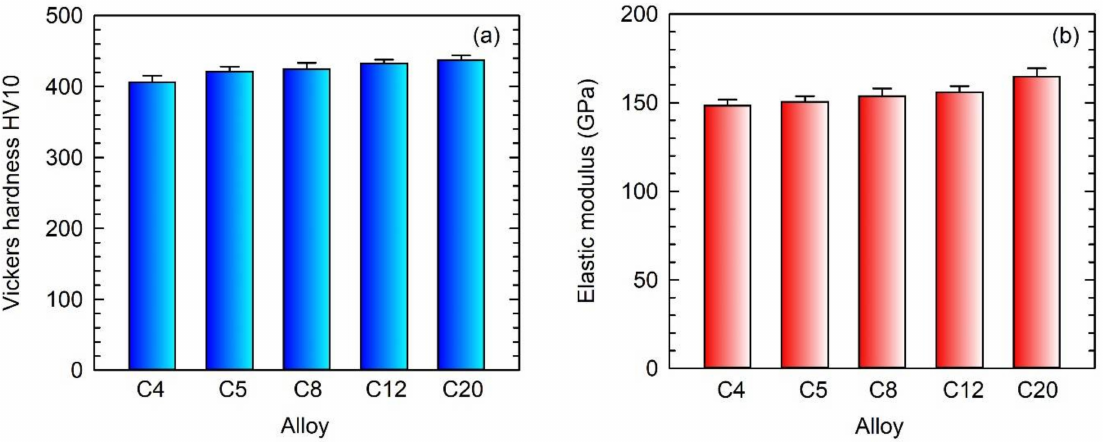
Figure 11. Vickers hardness and elastic modulus of the as-cast C4, C5, C8, C12, and C20 alloys: ( a ) Vickers hardness HV10; ( b ) Indentation elastic modulus. The studied alloys are marked in the